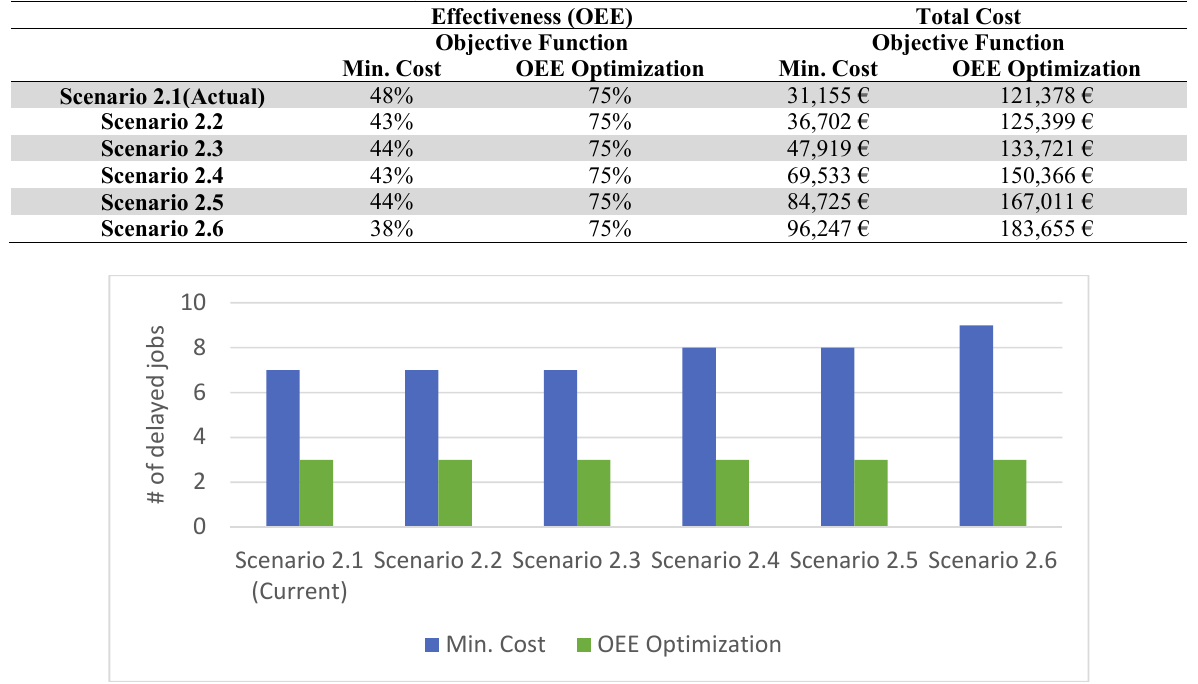
Effectiveness and cost for sensitivity analysis 2